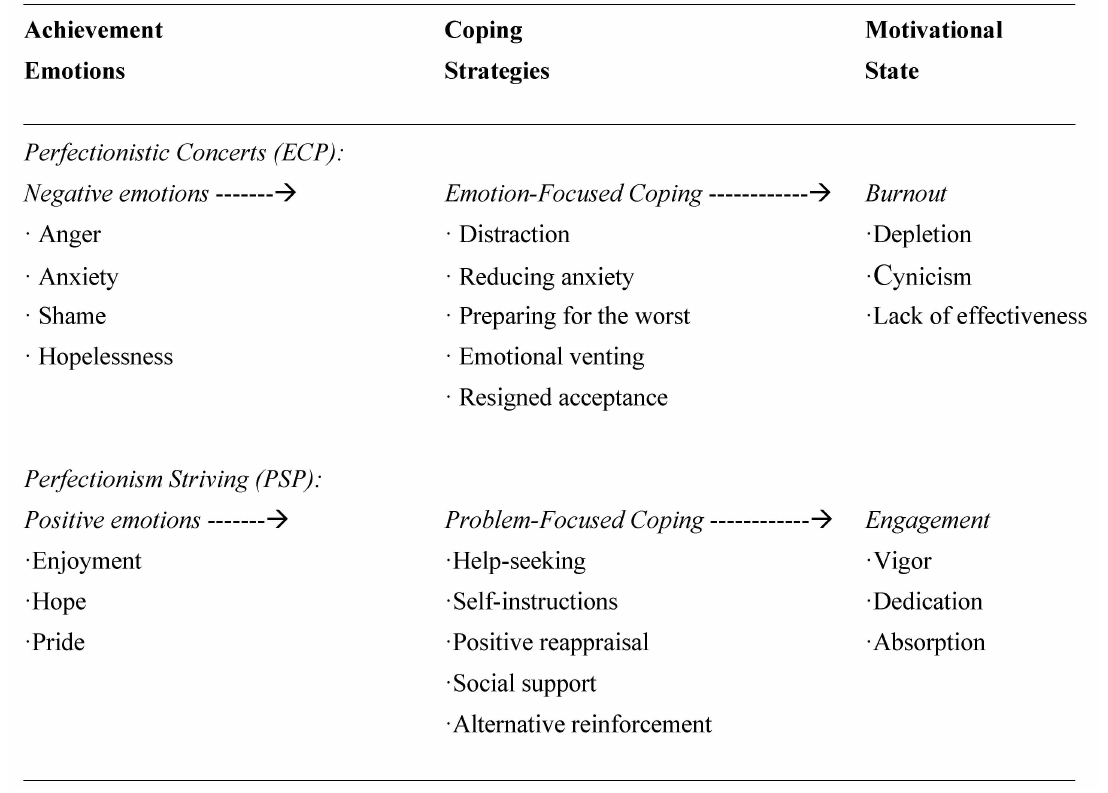
Figure 1. Relationship model between achievement emotions, coping strategies and engagement-burnout, based on the preview model [52] (pp. 151 −